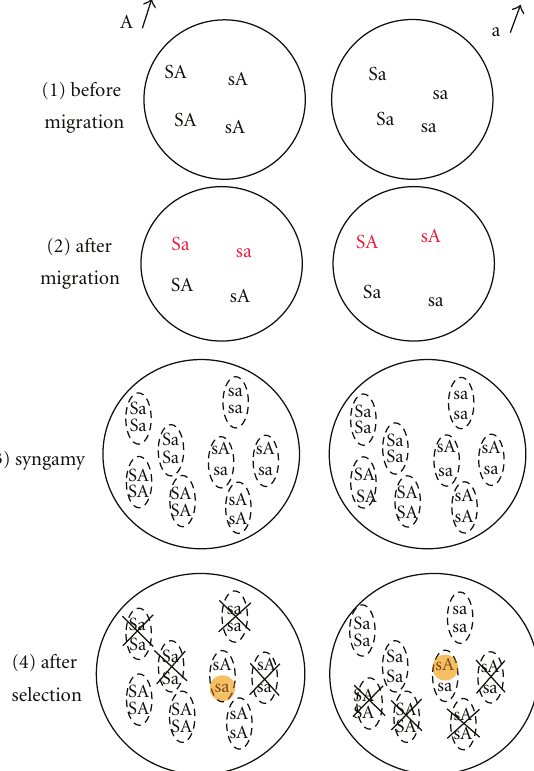
Figure 1: Indirect selection on a selfing/assortative mating modifier with local adaptation [53]. Sketches how a selfing or assortative mating modifier evolves in presence of local adaptation (for the sake of illustration, the S allele causes maximal assortment and s specifies random mating). Here assortment can be produced by selfing or assortative mating based on the genotype at the local adaptation locus (A mates with A and a with a). Before migration (step 1), consider two habitats with haploid individuals. On the left A allele is favored at a local adaptation locus, whereas a is favored on the right. To make things simple, we consider these alleles to be fixed where they are beneficial. At step 2, migration occurs between habitats (with m = 1/2, migrants in red). Then syngamy occurs in each habitat. The small circles represent diploid individuals. In each habitat, one can distinguish the subpopulation with full S-assortment allele (4 individuals on the left) and random mating s allele (4 individuals on the right). Importantly, at this step the S allele becomes positively associated to extreme aa and AA homozygotes (thus, variance in fitness is greater in the subpopulation with the S allele). Finally, selection occurs (favoring A on the left and a on the right, very strongly but in a codominant way in the illustration). At the end of this generation, the modifier has not changed in frequency (it is still 1/2). Yet, selection has generated LD between the random mating s allele and the locally inferior allele locally (the inferior allele is only found on the same chromosome as s in each habitat, orange dot). At the next generation, this LD will persist (it is decreased at most by one half by a round of free recombination) and cause indirect selection in favor of S. Note that if the locally beneficial allele is recessive (all heterozygotes eliminated on the right and the left), we see that direct selection occurs favoring S (its frequency rises to 2/3 on the sketch), but that less LD is generated. Exactly the opposite occurs if the local beneficial allele is